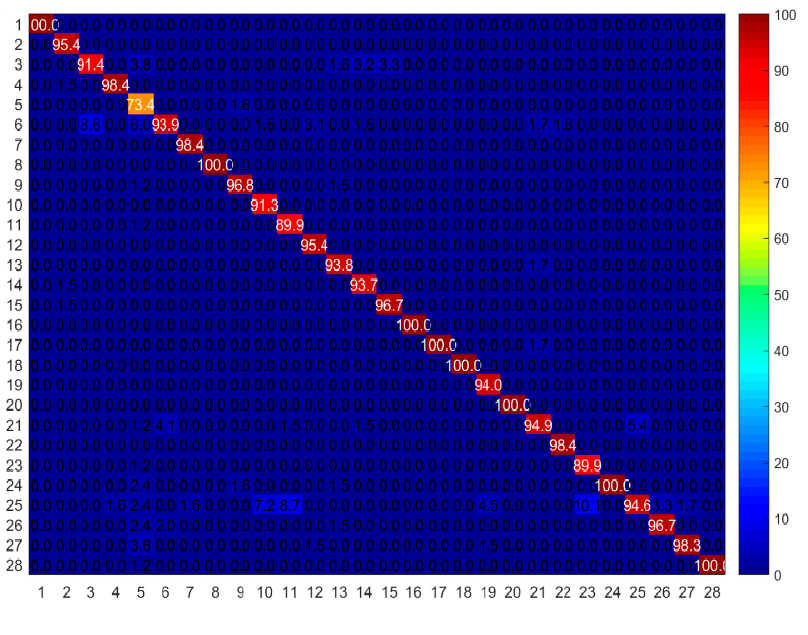
Figure 4. Confusion matrix of our proposed method and DGFLP method on the Extended Yale dataset on LBP features, where ( a ) is the confusion matrix of DGFLP method and ( b ) is the confusion matrix of our proposed method.